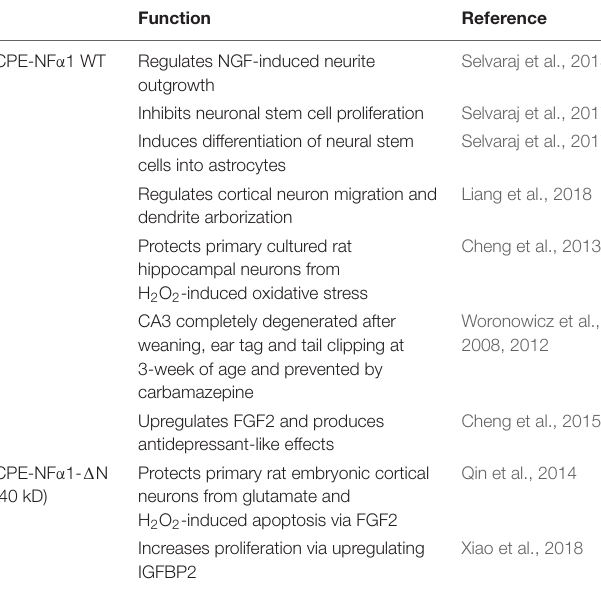
TABLE 2 | Neuroprotective and neurodevelopmental functions of CPE-NF α 1 WT and CPE-NF α 1- (cid:49) N.